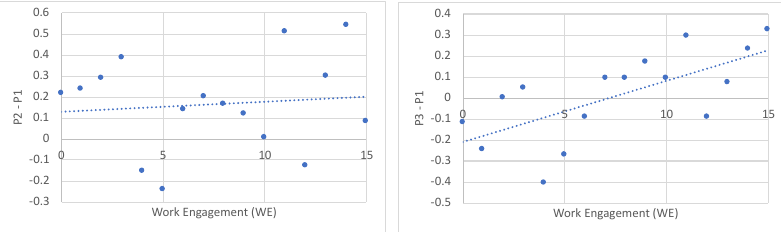
Figure 1. Work engagement as an independent variable and relative performance as a dependent variable